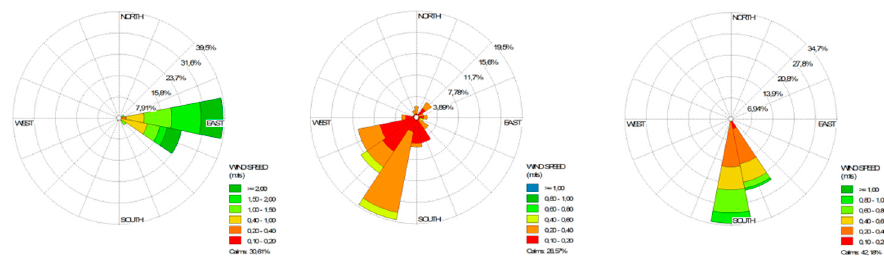
Figure 4. Predominant direction of wind for the period of analysis.